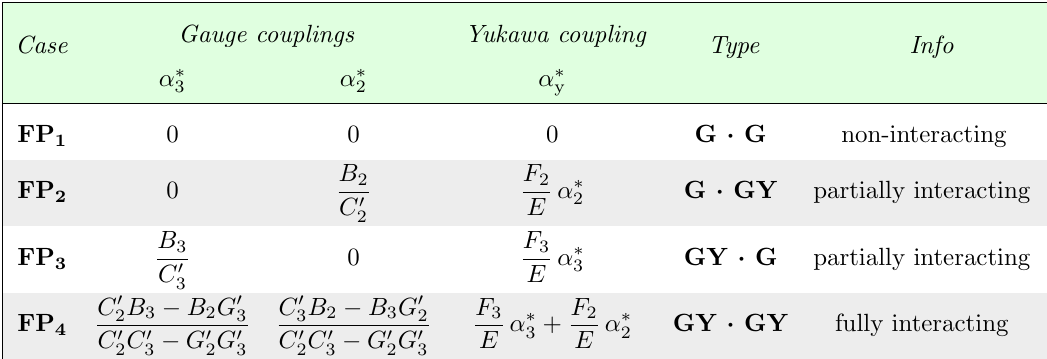
Table 2 . The four di(cid:11)erent types of UV (cid:12)xed points FP 1 {FP 4 in minimal BSM extensions of the SM with (3.7). The primed and unprimed loop coe(cid:14)cients are de(cid:12)ned in appendix A. We